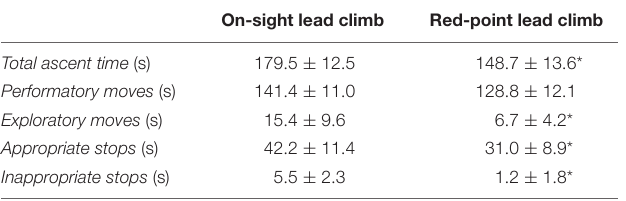
TABLE 1 | Total ascent time and duration of dynamic (performatory and exploratory moves) and static phases (appropriate and inappropriate stops time) in the on-sight and the red-point climb.